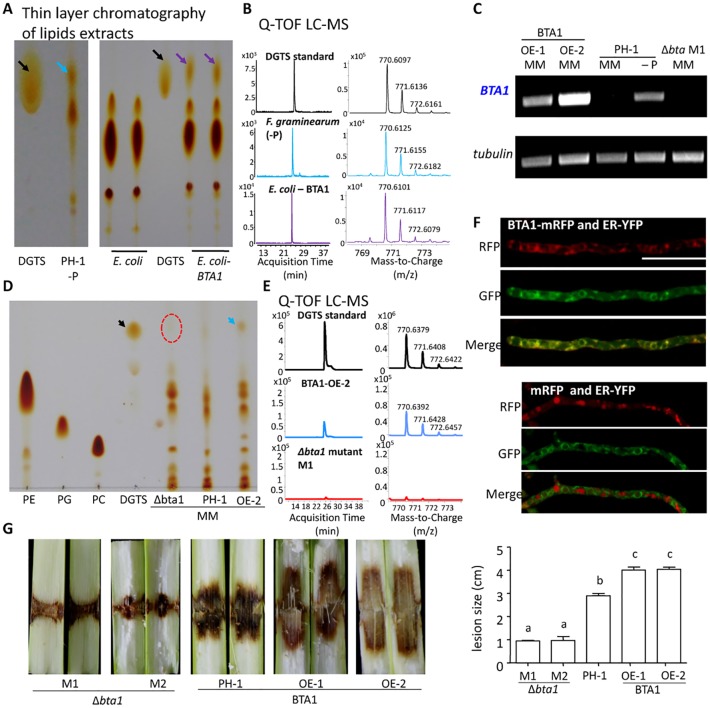
BTA1 is responsible for DGTS production.(A), (D) Thin layer chromatography (TLC) of lipid extracts from F. graminearum or E. coli expressing F. graminearum BTA1. (B), (E) Spots scraped from TLC plates (indicated by arrows) were applied to accurate-mass quantitative time-of-flight liquid chromatography mass spectrometry (Q-TOF LC MS) analysis. See Figure I in S1 Text for more lipid analyses. (C) RT-PCR results for BTA1 expression in various F. graminearum strains and conditions. (F) Subcellular localization of BTA1-mRFP in F. graminearum. ER: endoplasmic reticulum localized protein marker. White bar = 100 μm. (G) Virulence assays on maize stalks. Lesions were measured at 7 days after inoculation. Different letters indicate statistical differences among the strains according to Tukey’s multiple comparison test (P = 0.05), n = 3 independent experiments.